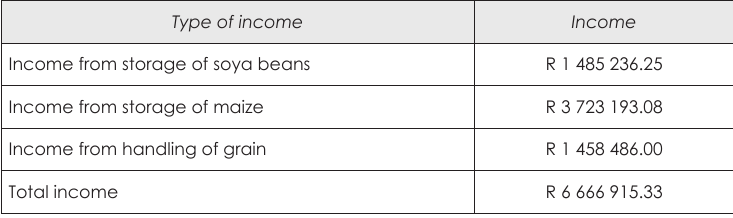
Table 7: Total gross income of the